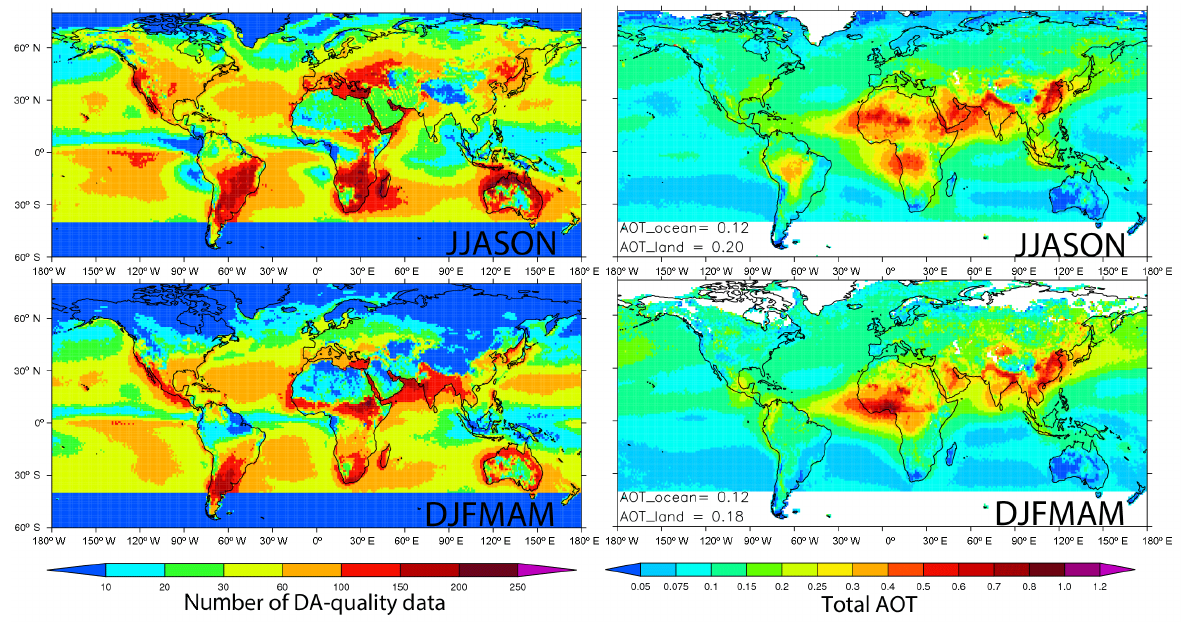
Figure 2. Properties of the 6-hourly 1 × 1 ◦ MODIS + MISR data assimilation quality AOT data for JJASON (June–November, upper) and DJFMAM (previous year December–May, lower) averaged over 2003–2013 (June 2003–May 2013): (left) total number of the DA-quality data, (right) seasonal mean of the total AOT at 550nm. Blank area indicates no available data. Annotations at the bottom left in the AOT figures show the area mean AOTs over ocean and over land averaged for 40 ◦ S–60 ◦ N.